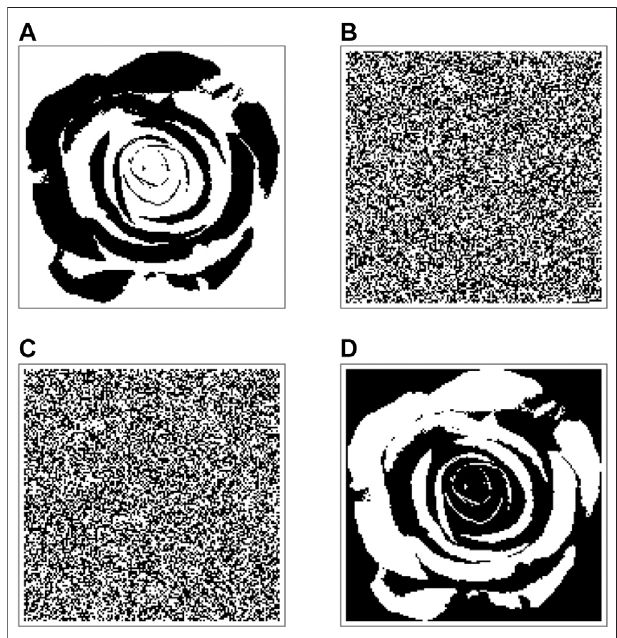
FIGURE 18 | (A) Input binary image with M × N pixels ( M (cid:1) 145, N (cid:1) 147). (B , C) Black-and-white picture coding the random initial condition assigned to the capacitor voltage (memristor state) in each cell of a M-CNN with same rows and columns as the input image. (D) Graphical illustration of the data stored in the memristive memory at the end of the data writing operation. The binary picture in (D) appears to be the logically inverted version of the black-and-white image in (A) , due to the convention, intentionally adopted here, to map each white (black) pixel of the input binary imagetoanegative(positive)oneV-valuedinputvoltageforthecorresponding M-CNN cell, and to code the memory content of each off (on) memristor at equilibrium through a black (white)